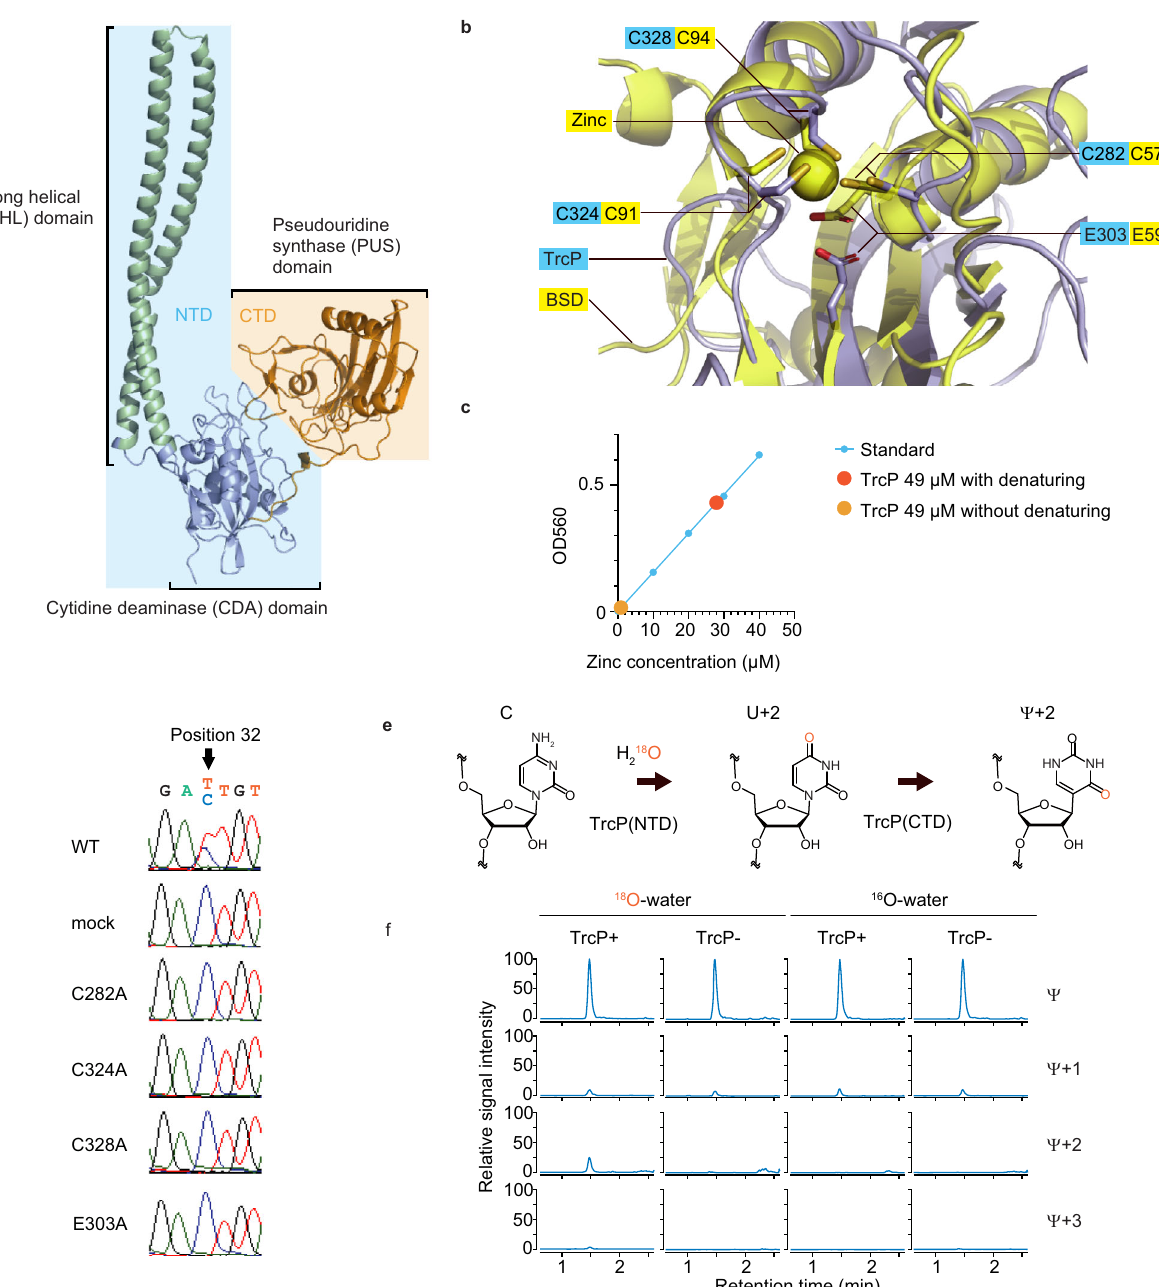
Fig. 3 | Reaction mechanisms of TrcP catalyzing C-to-U editing. a A structural model of TrcP protein generate by ColabFold 28 . TrcP is composed of two globular domains, the cytidine deaminase (CDA) domain (light blue) and pseudouridine synthetase (PUS) domain (orange), and a long helical (LHL) domain (green). NTD and CTD are shaded with light blue and light yellow, respectively. b Alignment of thepredictedcatalyticsiteintheTrcPCDAdomain(lightblue)withtheBlasticidin- S deaminase (BSD) (yellow). The residues of BSD and its coordinating zinc ion are shown in the yellow background, whereas the residues of TrcP are shown in the light blue background. Oxygen and sulfur residues are also colored red and gold, respectively. c Colorimetric measurement of zinc concentration of TrcP solution.